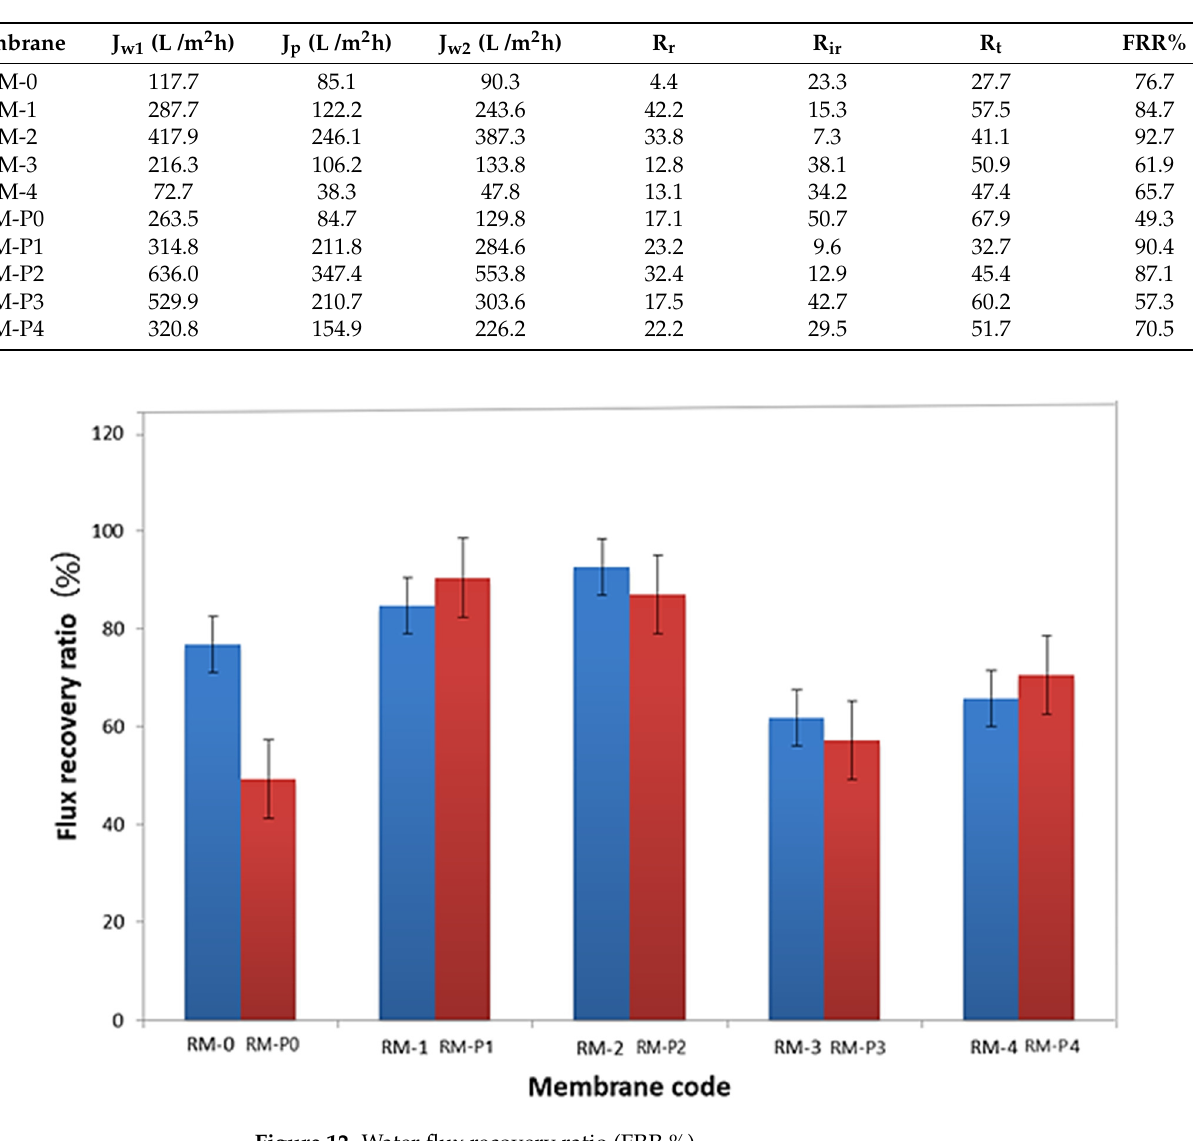
Table 4. Antifouling properties of prepared membranes.